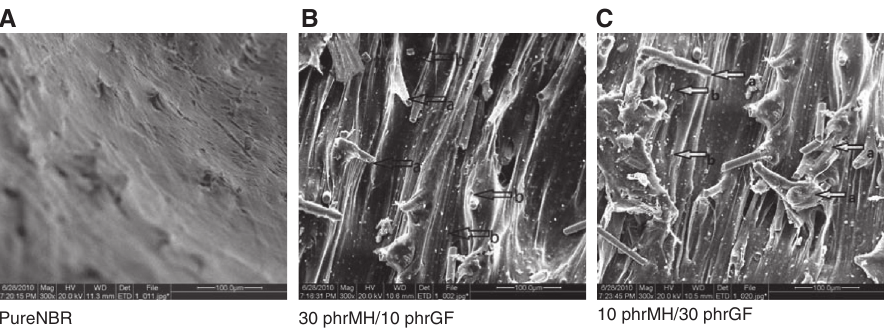
Figure 2 The 300% tensile stress curves for nano MH/GF/NBR composite materials.